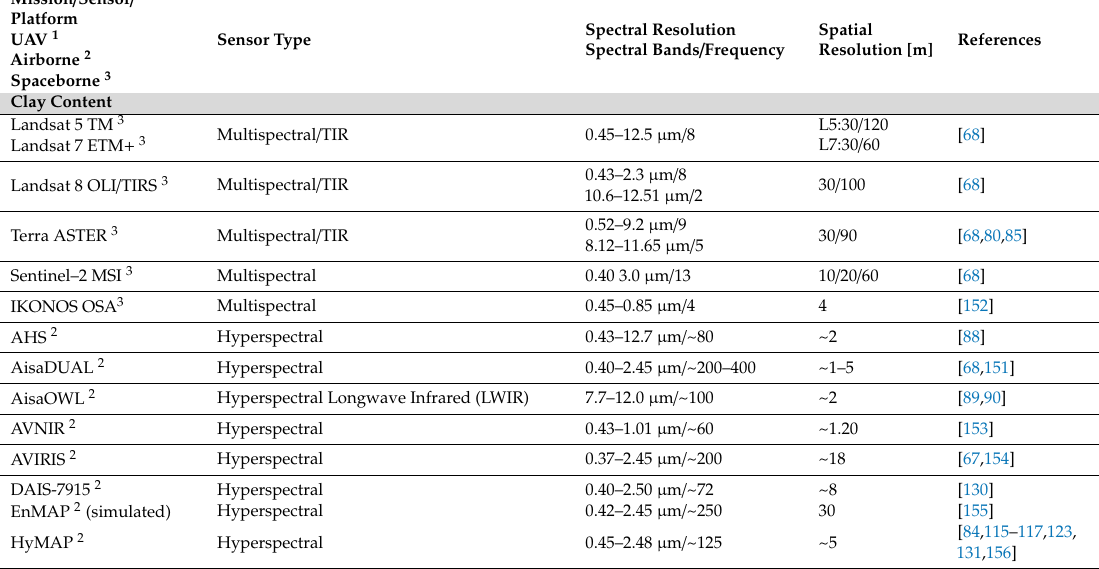
Table 1. Remote sensing (RS)-aided derived soil characteristics and soil traits. Mission / Sensor /